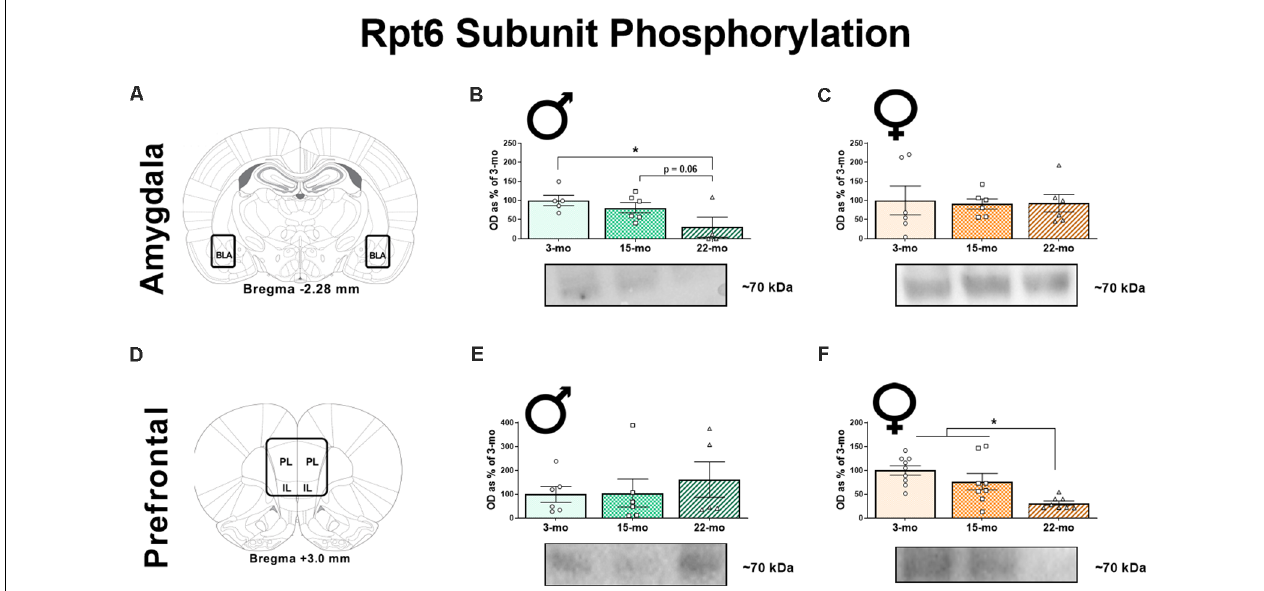
FIGURE 2 | Ninety minutes following the retrieval session, synaptic fractions were obtained in order to analyze the phosphorylation of the Rpt6 subunit using western blots. In the BLA (A) , 22-mo old males display reduced pRpt6 (B) , while females show no difference (C) . However, in the mPFC (D) , while males show no differences in pRpt6 (E) , females 22-mo old females display reduced pRpt6 (F) . Results are expressed as mean percentages of 3-mo old rats within each sex ( ± SEM). Blots have been cropped for clarity to show representative samples. Here, the mPFC is defined as the area including both the prelimbic cortex (PL) and infralimbic cortex (IL). *Indicates P <